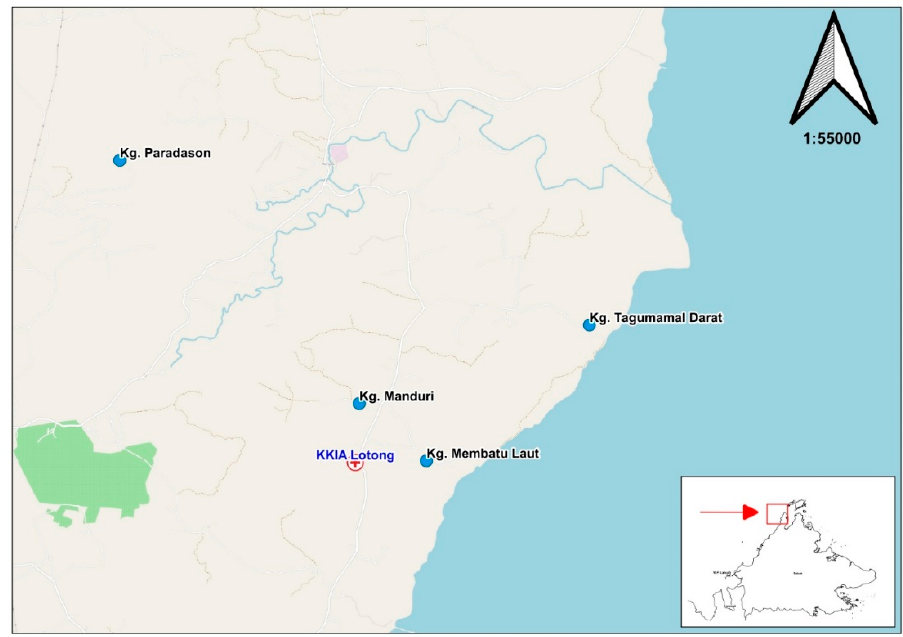
Figure 5. The study sites.